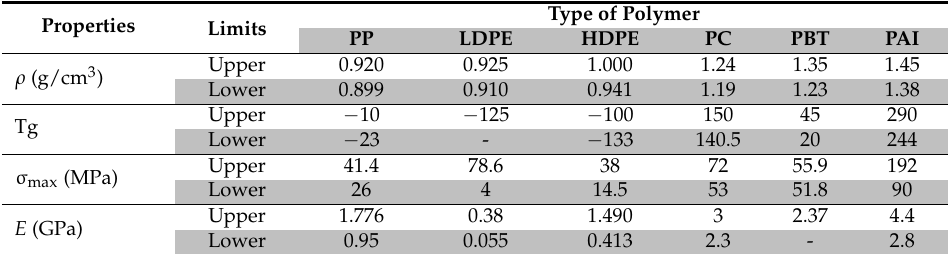
Table 1. The properties of various polymers [32].